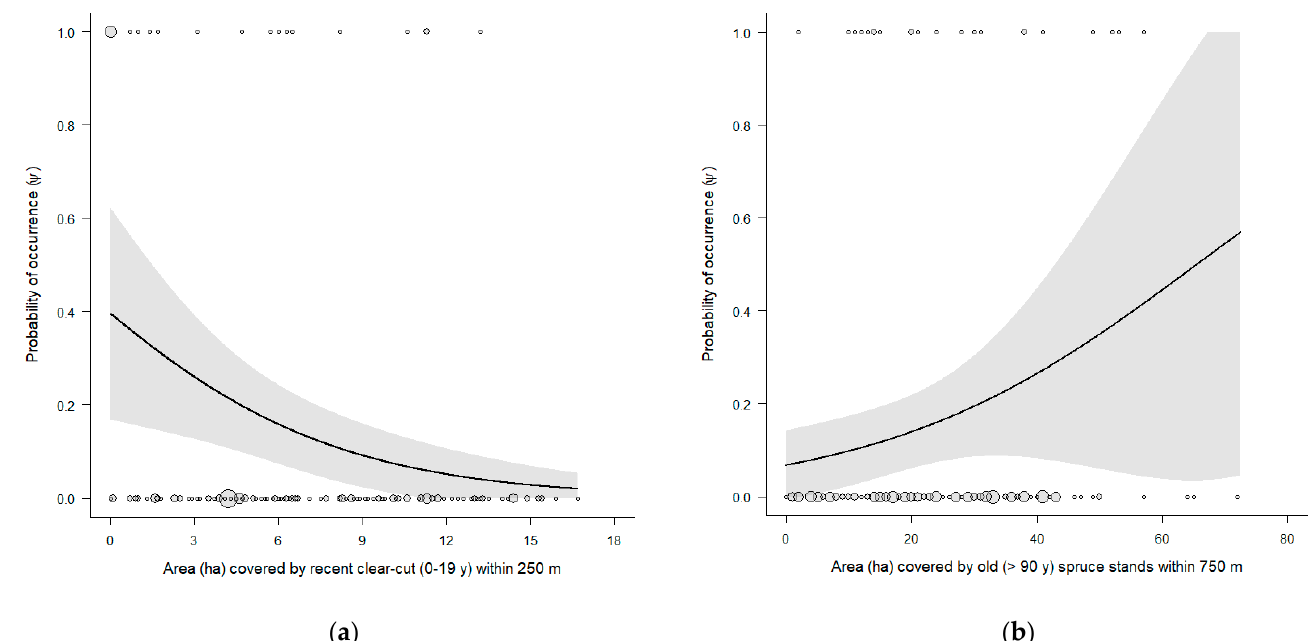
Figure 2. Influence on the occupancy of American Three-toed Woodpecker in managed boreal forest in eastern Canada of the area (ha) covered by ( a ) recent clear-cut stands at the stand scale (250 m radii) and ( b ) old spruce stands at the landscape scale (750 m radii). The shaded grey area represents 95% confidence interval, and symbols represent the distribution of raw data with symbol size proportional to the (log + 1) number of observations.